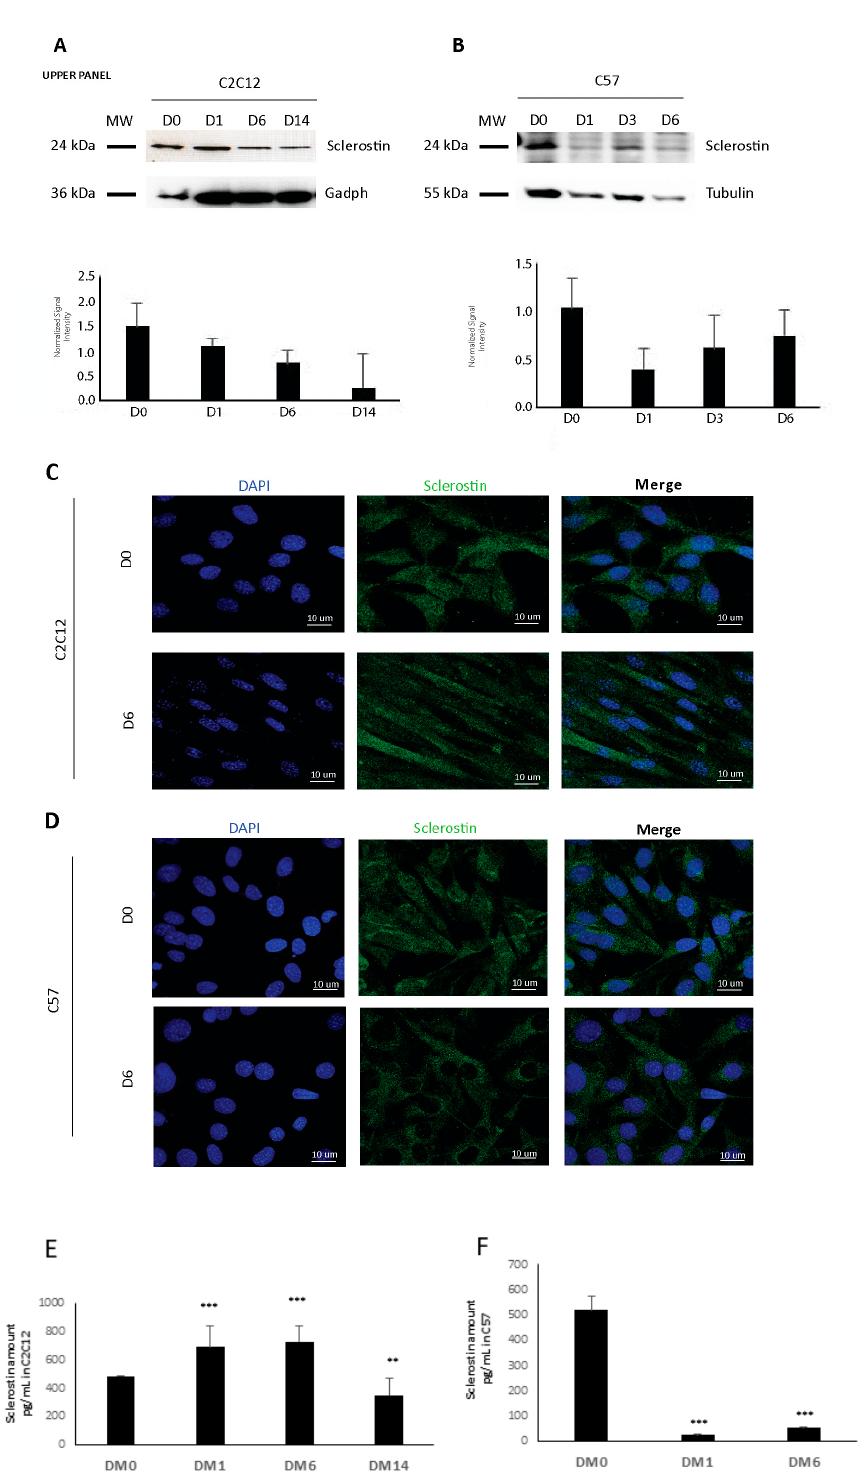
Figure 3. ( A , B ) C2C12 and C57 maintained in the cycling (DO) and differentiating conditions (D1–D3–D6–D14) were analyzed by Western blotting (upper panel). Forty ug of protein extracts were resolved by SDS-PAGE and sclerostin expression was revealed. GAPDH/actin or tubulin antibodies were used to normalize the signal intensity for at least three independent experiments (lower panel). ( C , D ) Immunofluorescence analysis of sclerostin in C2C12 and C57 cells in the growing (D0) and differentiating conditions (D6). ( E , F ) Quantitative analysis through ELISA assay of the sclerostin secreted in the media produced respectively by C2C12 and C57 cells in the cycling and differentiating conditions. Student’s t -test (vs. sample named DM0) was applied with p < 0.005 (**) p < 0.0005 (***). The experiment was repeated in